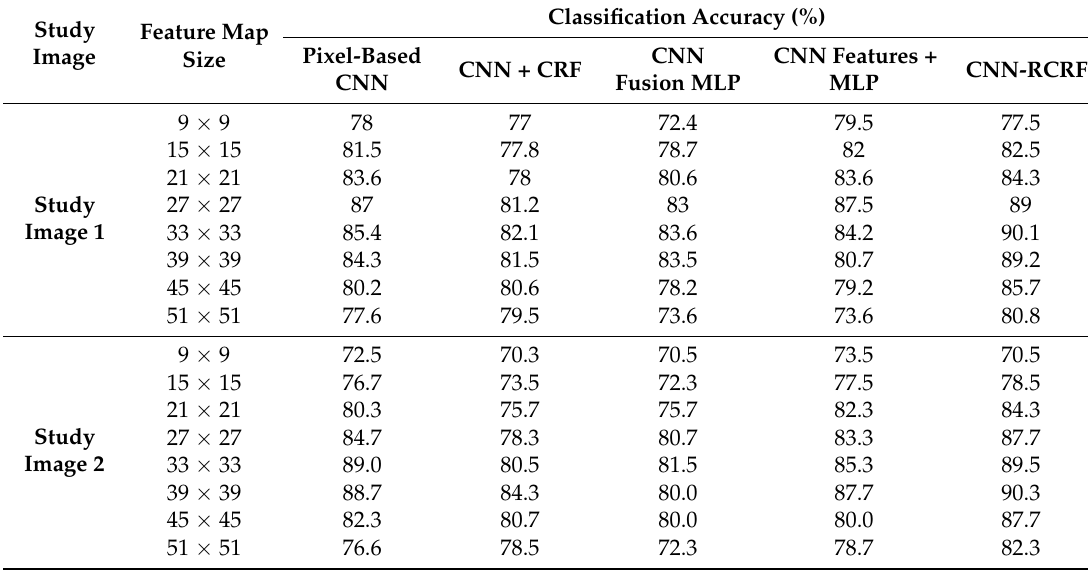
Table 3. Classification accuracy comparison of deep-model methods for eight feature map